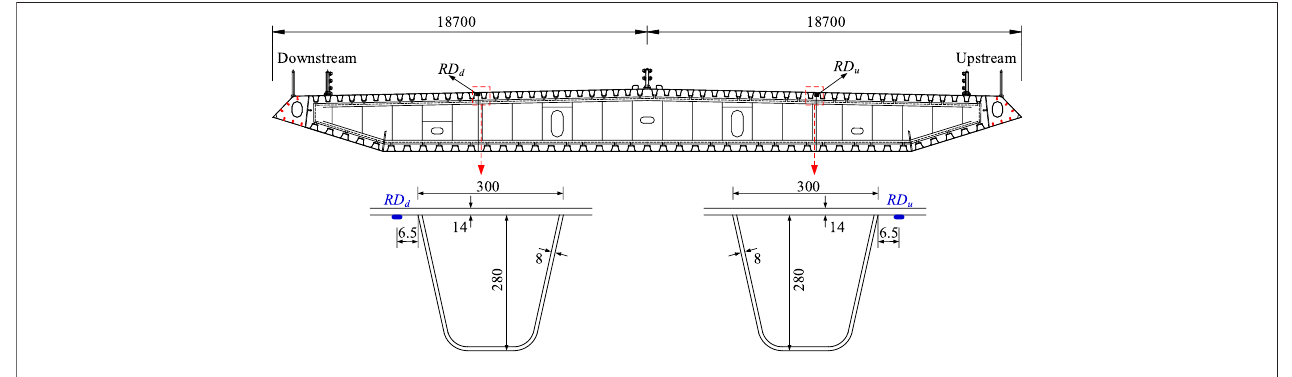
FIGURE 3 | Layout of strain sensors on the orthotropic steel deck (Unit: mm).